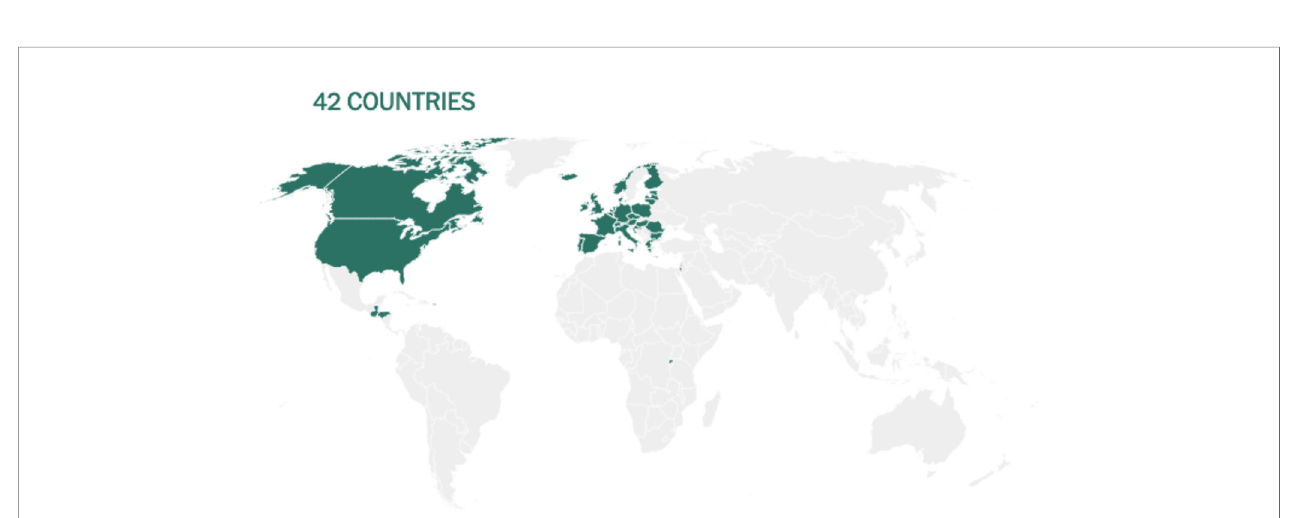
FIGURE 10 | Countries where the Moderna vaccine is being used as of May 10, 2021. Source: Our World in Data (https://ourworldindata.org/).